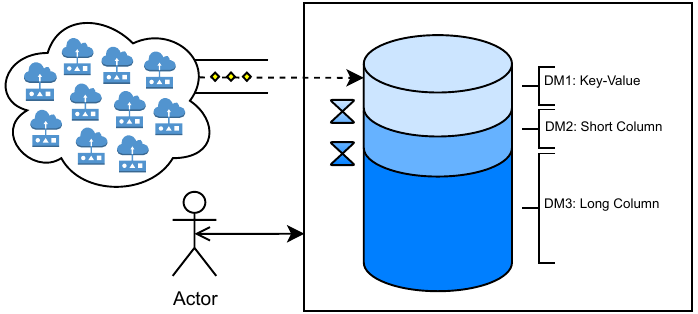
Figure 8. Simplification of a sample database following Cascading Polyglot Persistence, consistent in three different cascading data models. Data are ingested directly to Data Model 1, while the user can interact with the whole